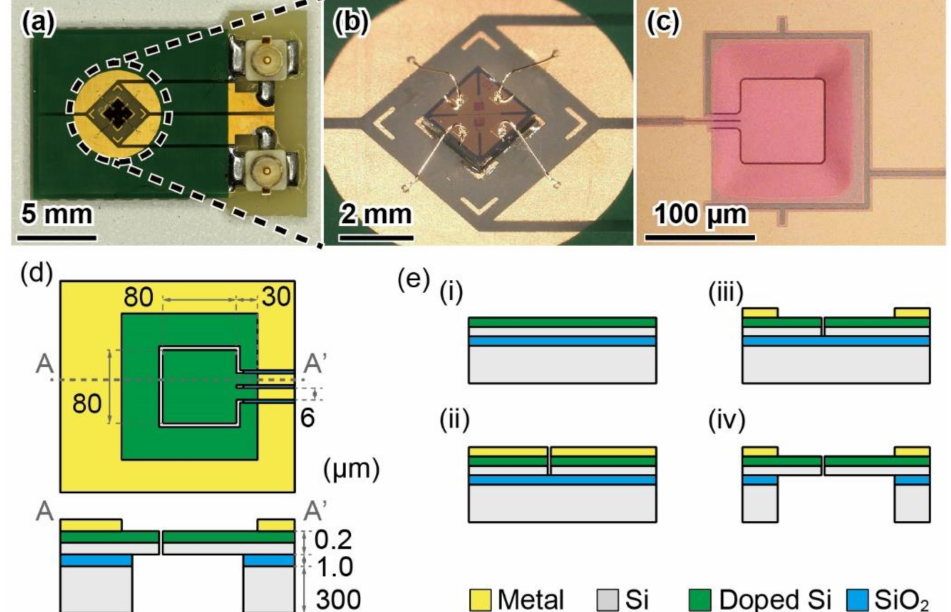
Figure 4. ( a ) Photograph of printed circuit board with sensor chip; ( b ) close-up view of sensor chip; ( c ) close-up view of piezoresistive cantilever. ( d ) Design of piezoresistive cantilever. ( e ) Fabrication process of piezoresistive cantilever: ( i ) Formation of piezoresistive layer on device Si layer; ( ii ) deposition and patterning of Au/Cr layer and etching of device Si layer; ( iii ) patterning of Au/Cr layer; ( iv ) etching of handle Si layer and SiO 2